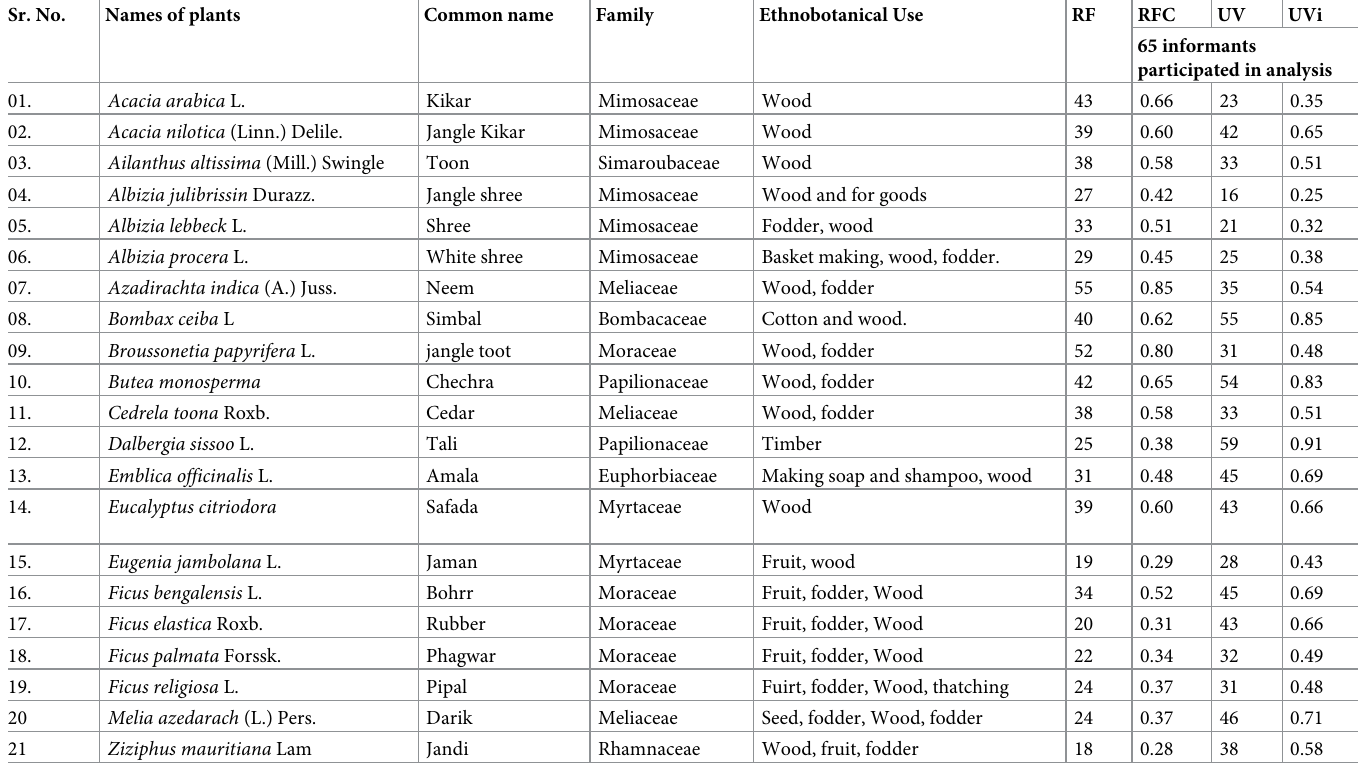
Table 4. Relative frequency of citation (RFC) and use value (UV) and of different important EB plants from SMR District Bhimber AJK, Pakistan. Sr.